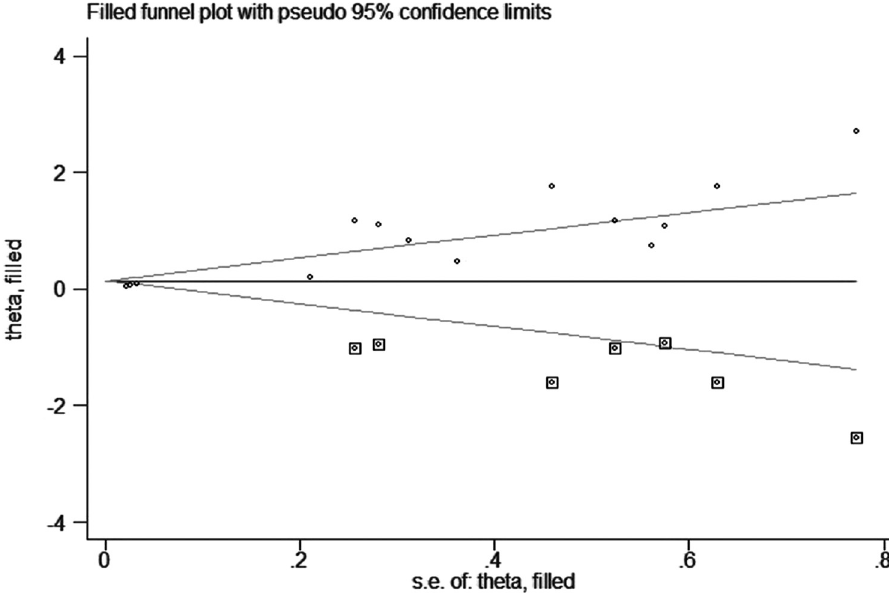
Fig 6. Trim and fill plot of publication bias on the association between advanced age and bullous pemphigoid